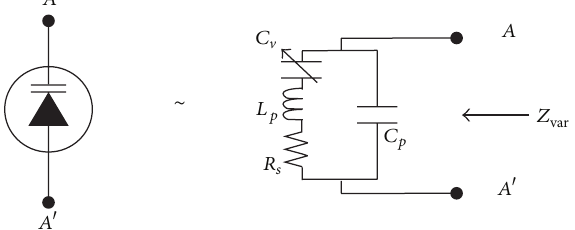
Figure 4: Equivalent circuit model of a varactor